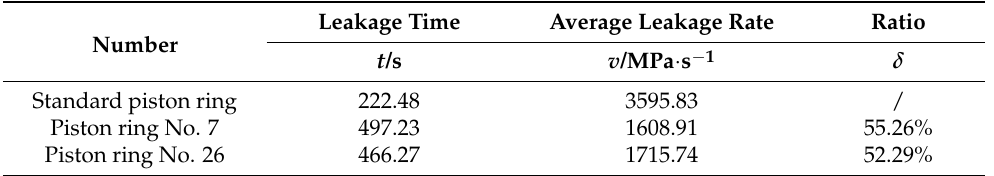
Table 3. Average leakage rate and rate reduction